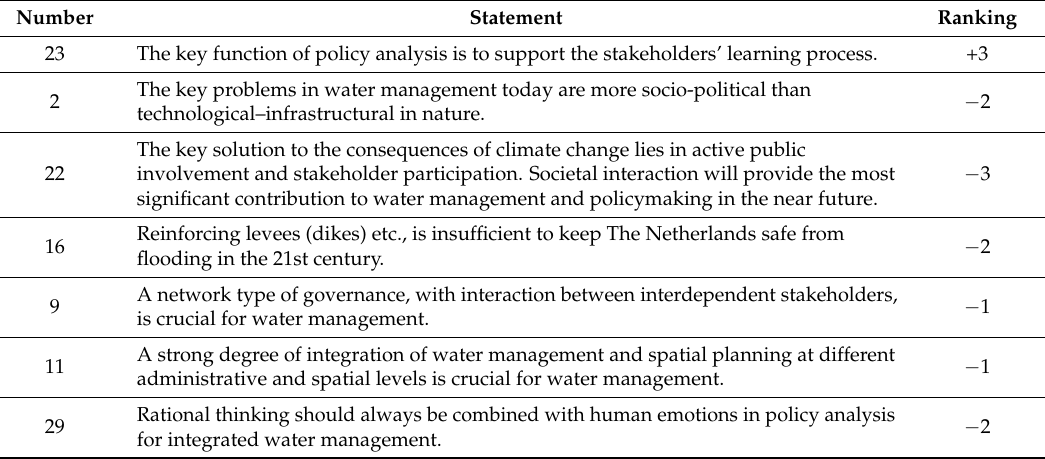
Table 5. Distinguished statements about IWRM in frame